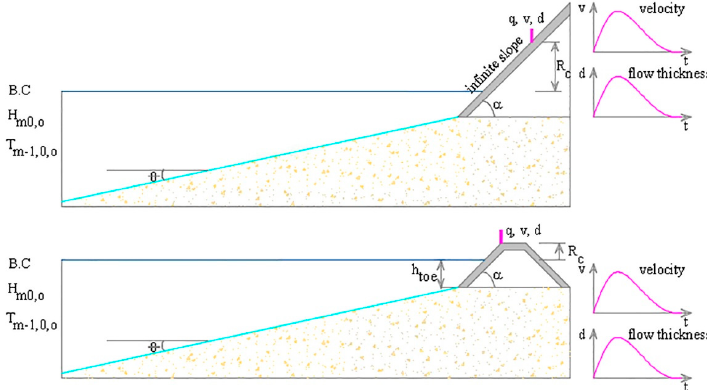
Figure 4. Wave overtopping over an infinite slope and a real sea dike.